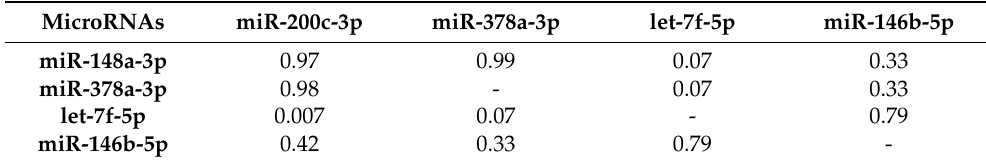
Table 3. Values of the relative activities of seven IgGs and sIgAs in the hydrolysis of five mi- Table 4. Values of correlation coefficients between concentrations of five microRNAs in human milk croRNAs, their average values, and correlation coefficients (CCs), and differences between groups plasma * . of parameters ( p ). MicroRNAs miR-200c-3p miR-378a-3p let-7f-5p miR-146b-5p miR-148a-3p 0.97 0.99 0.07 0.33 miR-378a-3p 0.98 - 0.07 0.33